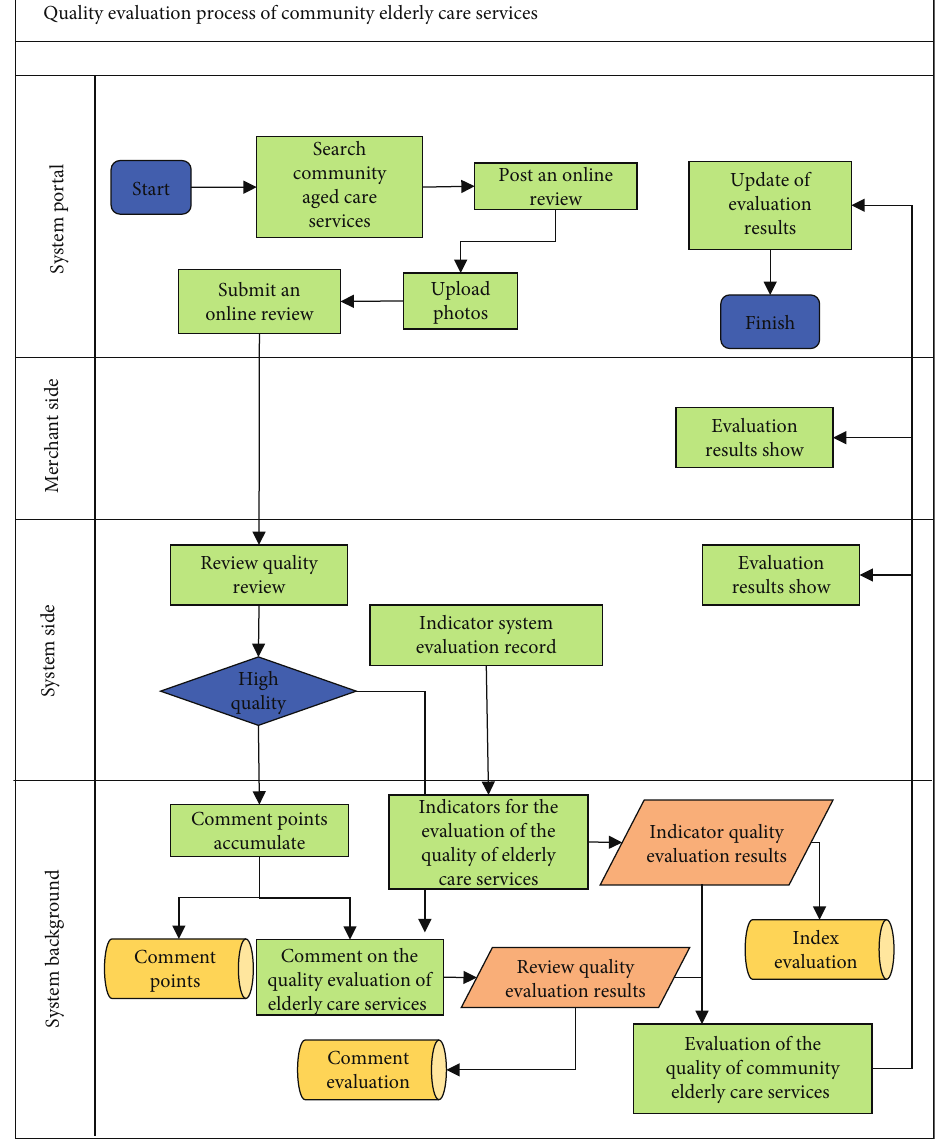
Figure 1: Schematic diagram of the business process of the community elderly care service quality evaluation